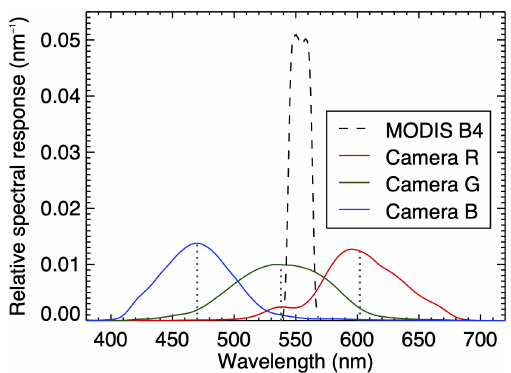
Figure 3. Relative spectral response functions for the three cam- era channels (colored lines: R, G, and B). The vertical dotted lines denote the respective central wavelengths. Dashed black line: RSR function for MODIS spectral band